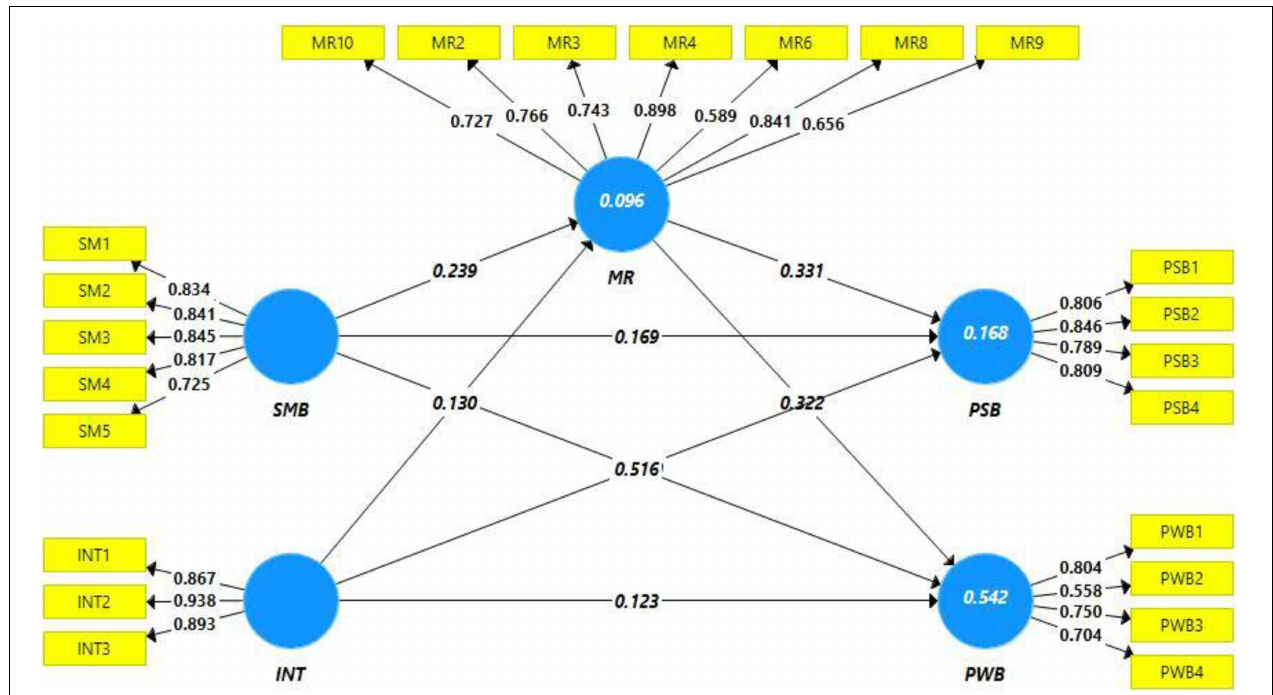
FIGURE 2 | Path estimates and outer loadings.